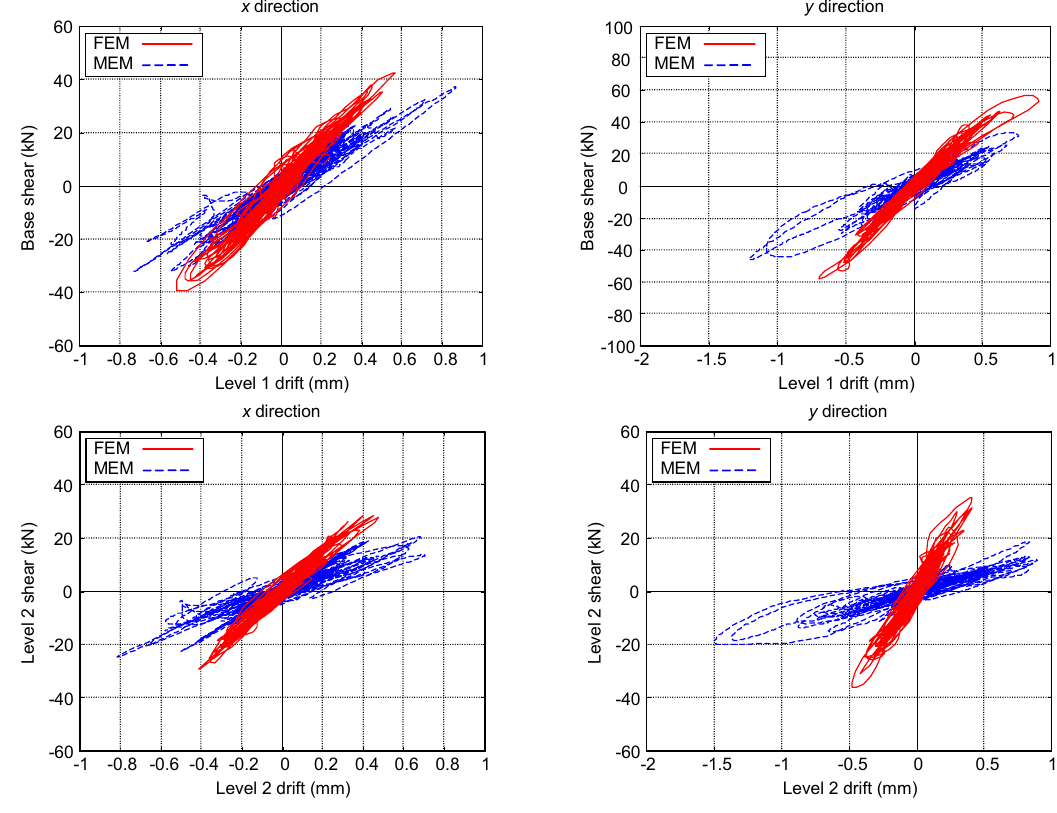
Figure 16. Shear forces vs. corresponding drifts for the analyses with nominal PGA = 0.30 g. Responses in terms of displacements and accelerations are less significant for non-linear analyses.